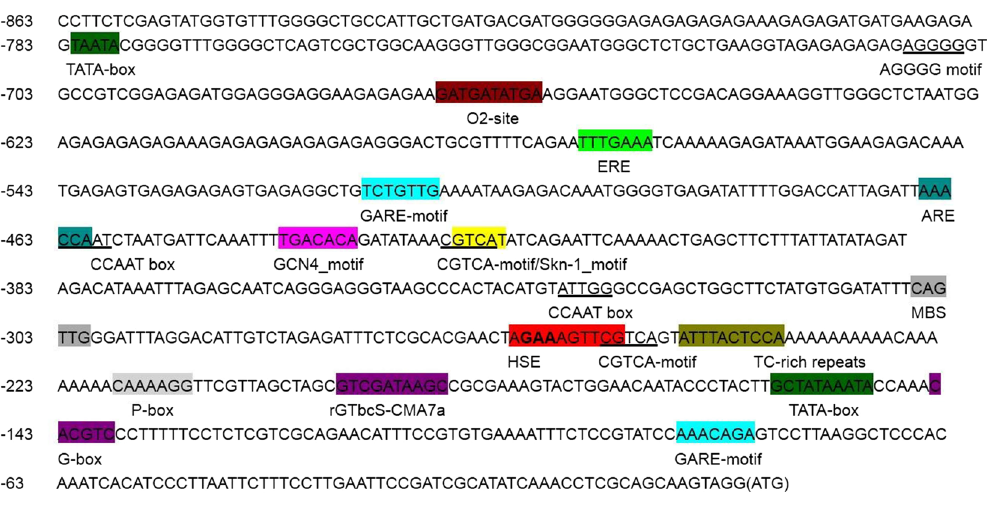
Figure 8. Analysis of the promoter sequences of CsHSP17.2 using the PlantCARE promoter motif analysis tool. The start codon is shown in parentheses. The underlines and different colors signify different functional elements.